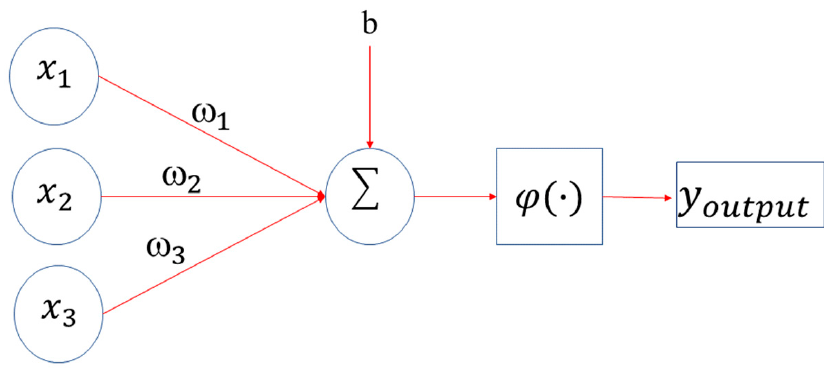
Figure 5. Illustration of the operations performed by each neuron in the ANN.